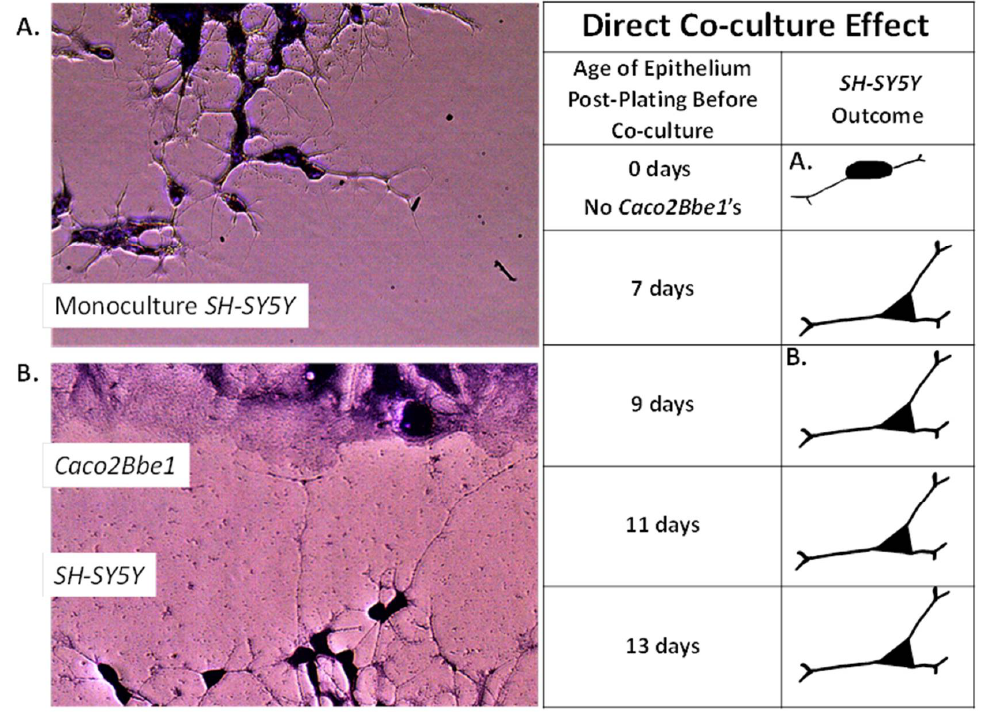
Figure 1. The SH-SY5Y neuronal phenotype in response to direct co-culture with Caco2Bbe1 . The manner of swiping and assessing the Caco2Bbe1 cells is described under Methods and in legends of Figures 2 and S1. A suspension of SH-SY5Y cells was added to the swiped open wells of Caco2Bbe1 cells (without inserts) in complete (10% FBS) media. The experimental variables were the presence and stage of epithelial cells prior to swiping. Six days after adding the SH-SY5Y’s, the media was removed by washing, the remaining cells were stained with crystal violet, and photographs were made using 40 × phase contrast microscopy. The images show: ( A ) control SH-SY5Y cells in empty wells without Caco2Bbe1 (cid:48) s (same source, plating density, media, and time of growth), and ( B ) experimental SH- SY5Y’s cells with their neurites extending toward the Caco2Bbe1 cells in co-culture. At the earliest epithelial stage of swiping (7-day-old Caco2Bbe1 (cid:48) s post-plating), the cells had reached confluency only one day prior. By comparison, based on studies performed later with transmembrane electrical resistance, the Caco2Bbe1 cells should have achieved full maturity by 11 days in pre-culture. As shown in the drawings, all stages of Caco2Bbe1 maturation were equally effective on neurite out-growth in the SH-SY5Y cell